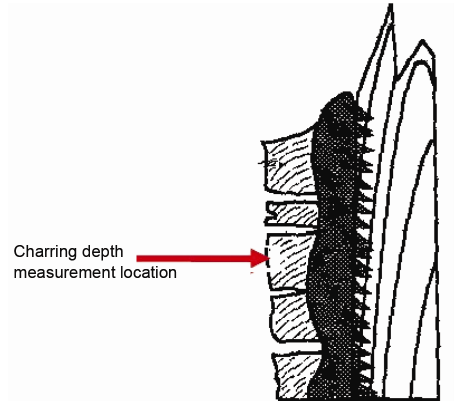
Fig. 6. Measurement of charring